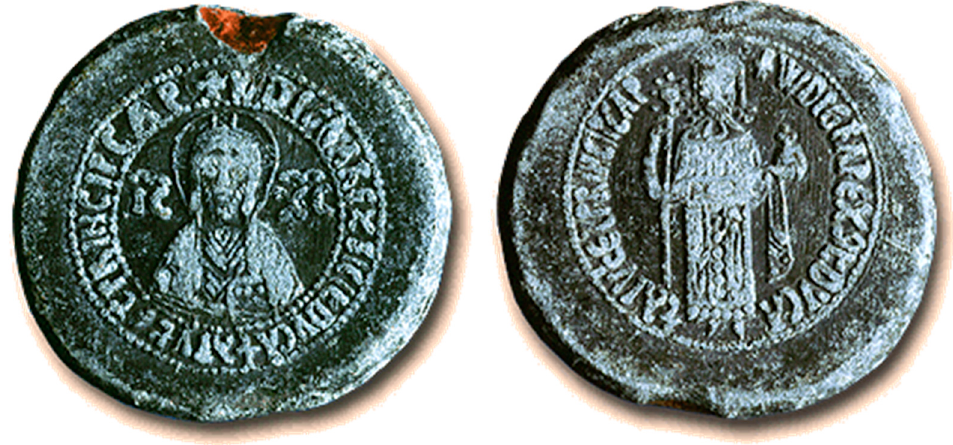
Figure 1. Bull of William II of Hauteville, obverse and reverse of impression on metal, March 1184. Palermo, Biblioteca Centrale della Regione Siciliana, Tabulario della Cattedrale di Monreale, diploma n. 50. Image published in: [3] (Figure 5).